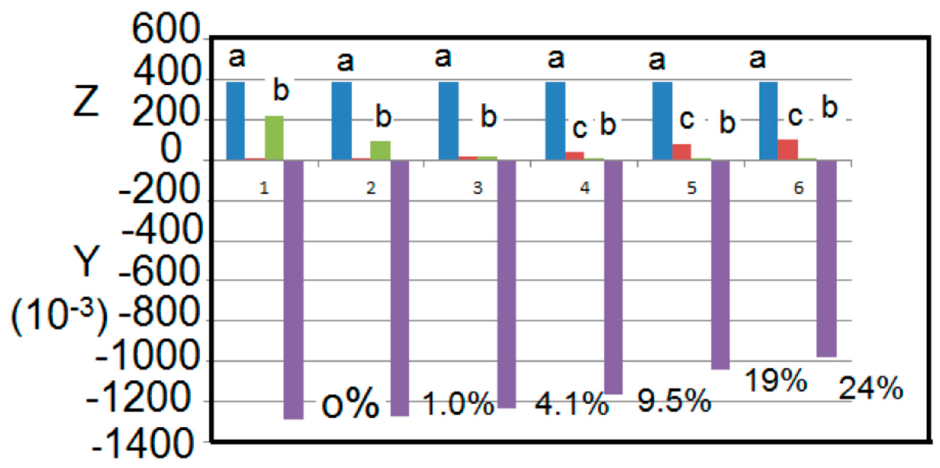
Figure 3. Carbon dioxide sensor responses to different concentrations of methane. Y = Sensor response; Z = Concentration. Group 1 a: CO 2 concentration, 390 ppm, b: Ratio of carbon dioxide/methane, c: methane concentration 1.8 ppm; Group 2 a: CO 2 concentration, 390 ppm, b: Ratio of carbon dioxide/methane, c: methane concentration 4.25 ppm; Group 3 a: CO 2 concentration, 390 ppm, b: Ratio of carbon dioxide/methane, c: methane concentration 18 ppm; Group 4 a: CO 2 concentration, 390 ppm, b: Ratio of carbon dioxide/methane, c: methane concentration 40 ppm; Group 5 a: CO 2 concentration, 390 ppm, b: Ratio of carbon dioxide/methane, c: methane concentration 80 ppm; Group 6 a: CO 2 concentration, 390 ppm, b: Ratio of carbon dioxide/methane, c: methane concentration 100 ppm. Reproduced with permission from Reference [5]. Nonappearance of c in 1, 2 and 3 indicates negligible values.